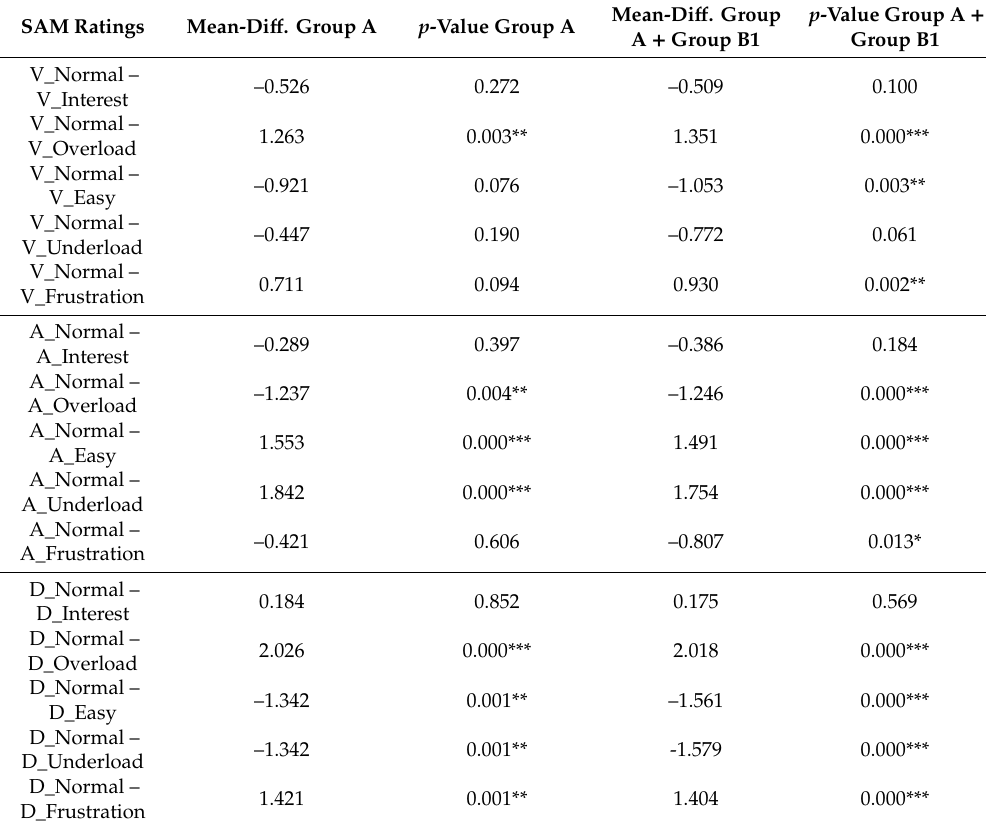
Table 3. Post-hoc Newman-Keuls corrections for the Valence (V), Arousal (A), and Dominance (D) ratings between all sequences compared to Normal . Mean-Di ff erences (Mean-Di ff .) and p -values are